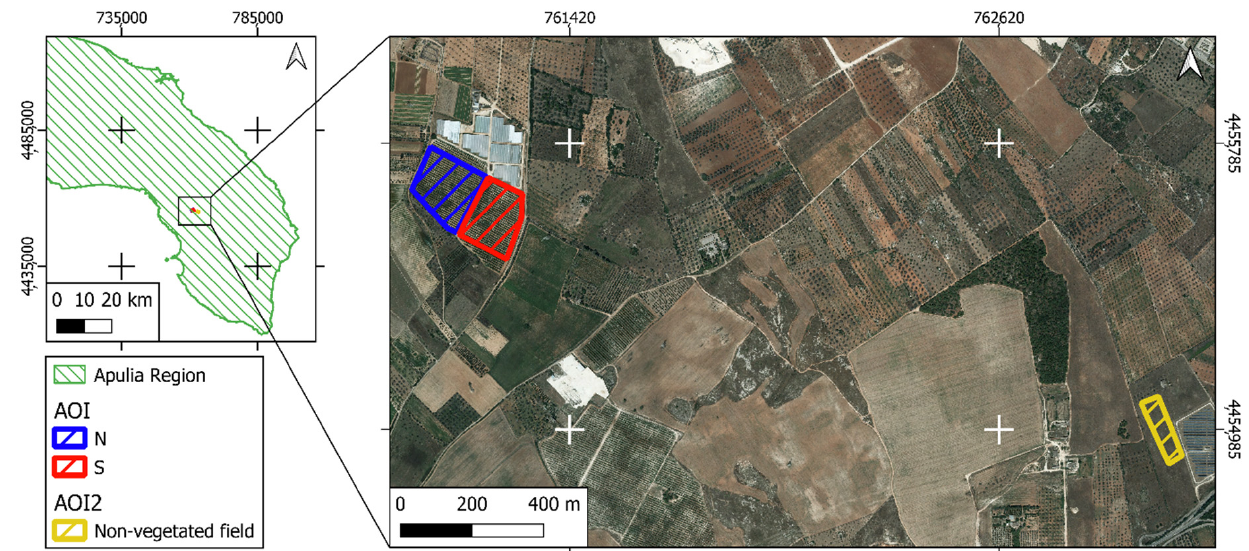
Figure 3. Spatial disposition of AOI and AOI2. Pomegranate plots N and S are represented with blue- and red-lined polygons, respectively. The yellow-lined polygon refers to the non-vegetated field. (The reference system is WGS 84/UTM 33N, EPSG: 32,633). Parameters α (x,y) and β (x,y) were locally mapped once the orchard pattern (in terms of the size and direction of the rows) was known and a proper vector graticule was aligned to the S2 tile. The orchard rows were initially represented using a line vector layer interactively edited in QGIS. The rows were interpreted from a high-resolution 2019 aerial orthimage from AGEA (Italian Agency for Payments in Agriculture). The orchard owner confirmed that the orchard pattern did not change between 2019 and 2021. Lines representing the middle of the pomegranate rows were drawn and saved as vector shapefiles. Successively, a buffer of 1.5 m was generated around lines (B) to map the expected area covered by pomegranate canopy (about 3 m wide).